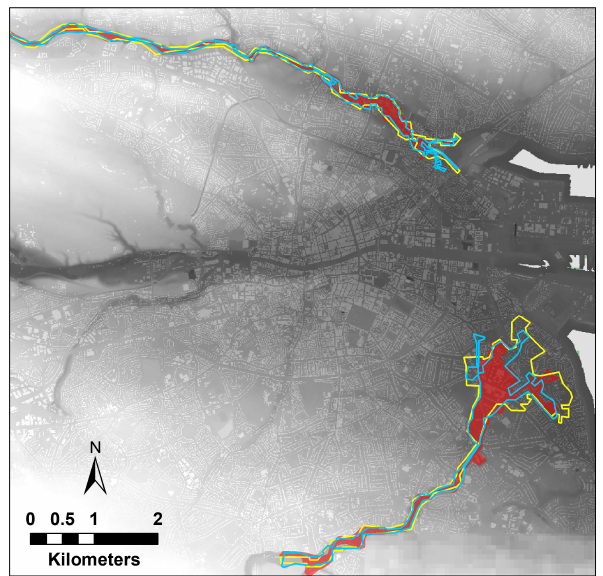
Figure 3. Hydraulic model calibration results. Red shaded area shows observed flood extent. Blue outline shows flood outline from 10m resolution model. Yellow outline shows flood outline from 50m resolution model. Underlying DEM is 10m